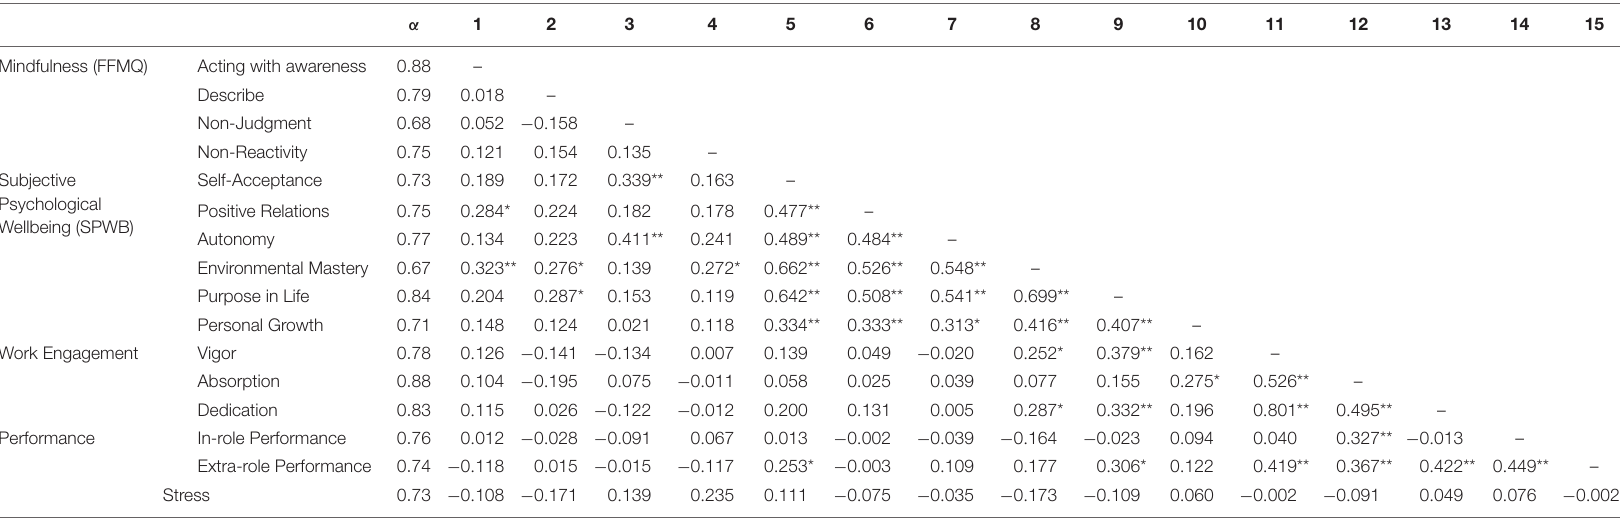
TABLE 3 | Cronbach’s α and correlations for all sub scales at pre intervention time.